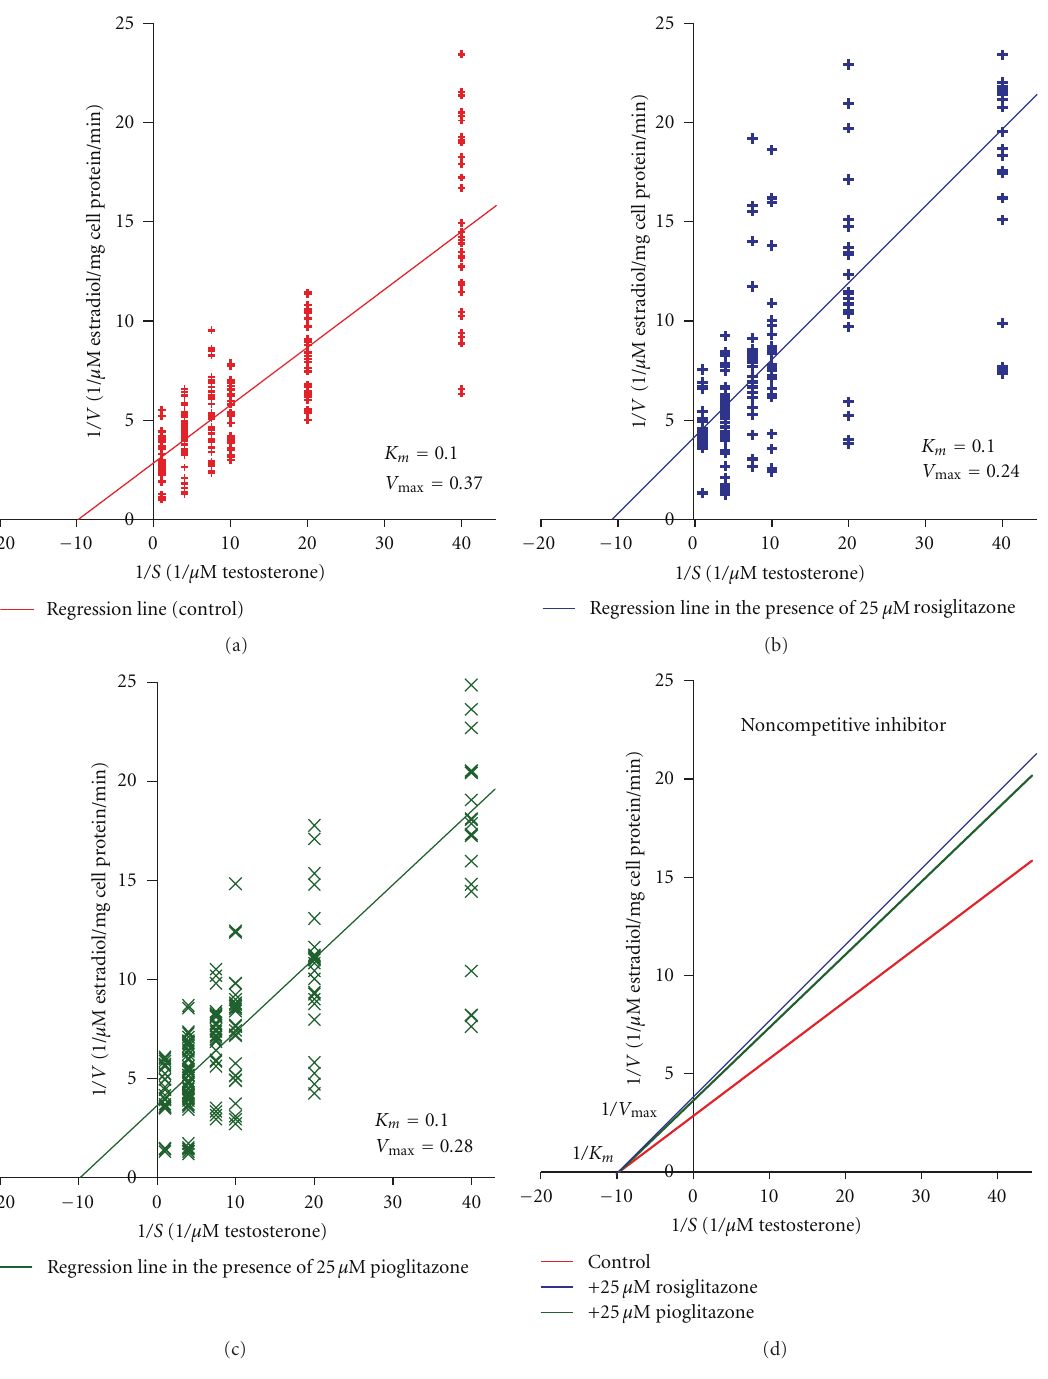
Figure 1: E ff ects of TZDs on aromatase enzyme kinetics when testosterone was used as substrate. (a) The Lineweaver-Burk plot (reciprocal velocities of aromatase activity against reciprocal testosterone concentration) in the absence of rosiglitazone or pioglitazone. (b) The Linewe- aver-Burk plot in the presence of rosiglitazone. (c) The Lineweaver-Burk plot in the presence of pioglitazone. (d) Comparison of the Linewea- ver-Burk plots in the presence or absence of rosiglitazone or pioglitazone. V = velocity; S =